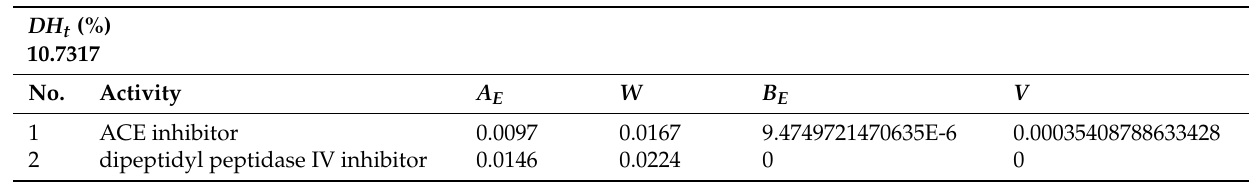
Table A4. A E , DH t , W , B E and V values from RubisCO of Halophila stipulacea . In silico enzymatic cleavage carried out by using trypsine.